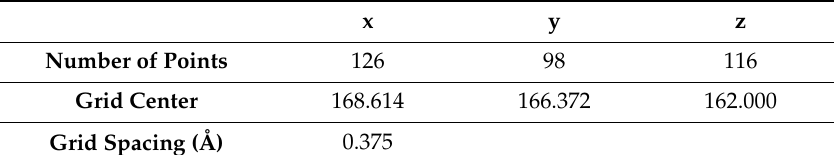
Table 5. Grid parameters for molecular docking analyses on human